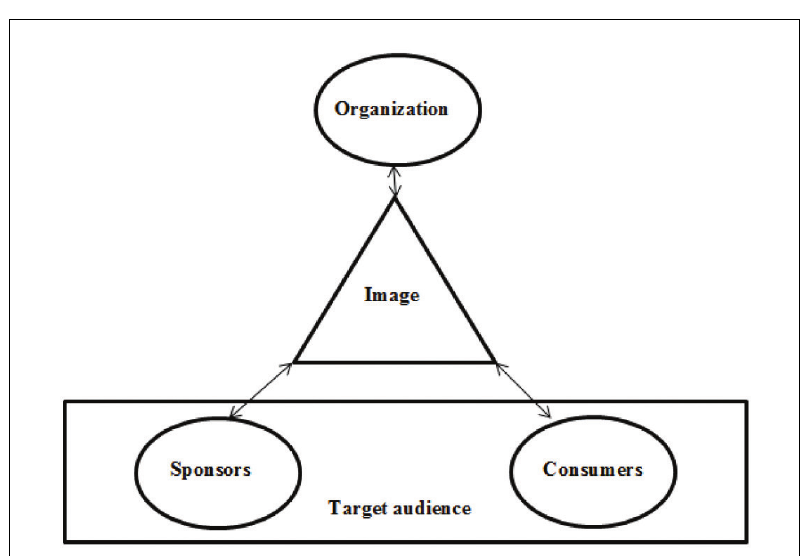
Figure 2. Theoretical model of sports or - ganization image formatting (Virvilaite & Dilys,